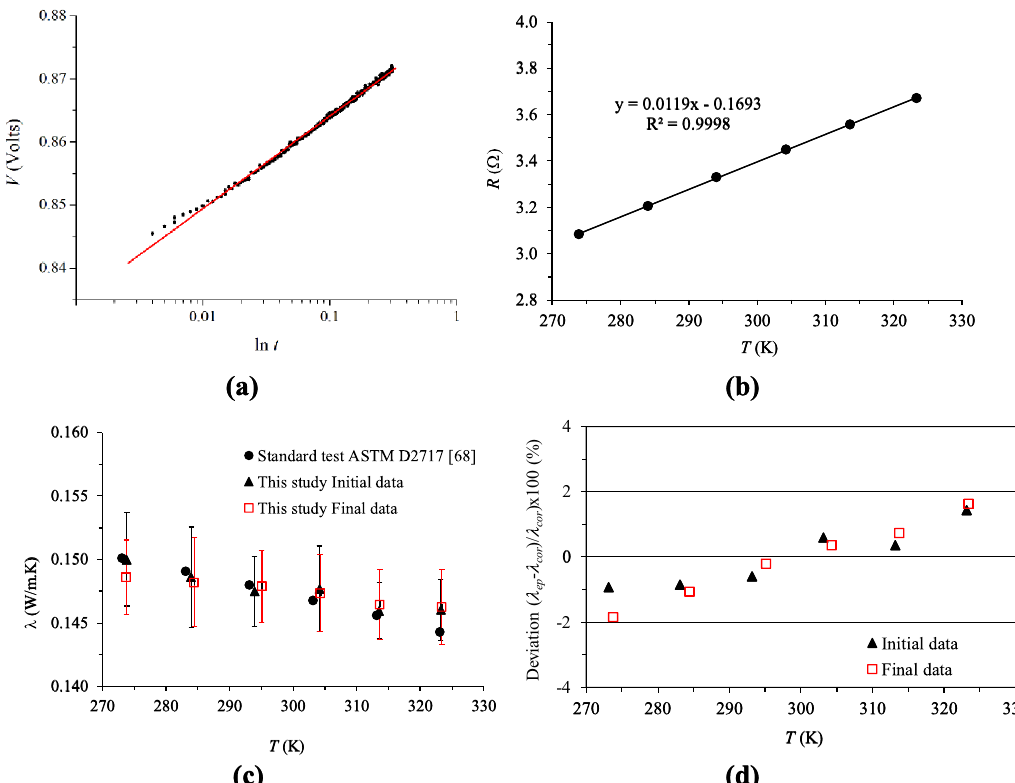
Figure 5. Typical discrete heating curve showing the voltage drop in the platinum wire, V , as a function of time for the C 60 NF prepared by dispersing 0.6 v/v% in C 10 H 12 at 293.15 K and 250 mA (The straight line represent the fitting to Eq. (8)) ( a ), variation of the wire resistance, R, with temperature, T ( b ), measured λ of C 10 H 10 O 4 as a function of T following the ASTM D2717 standard test 68 to calibrate the wire before (Initial data) and after (Final data) testing base liquids and NFs ( c ) and deviation from the tabulated values of the measured λ ( d ). Microsoft Excel 2016 was used to generate these